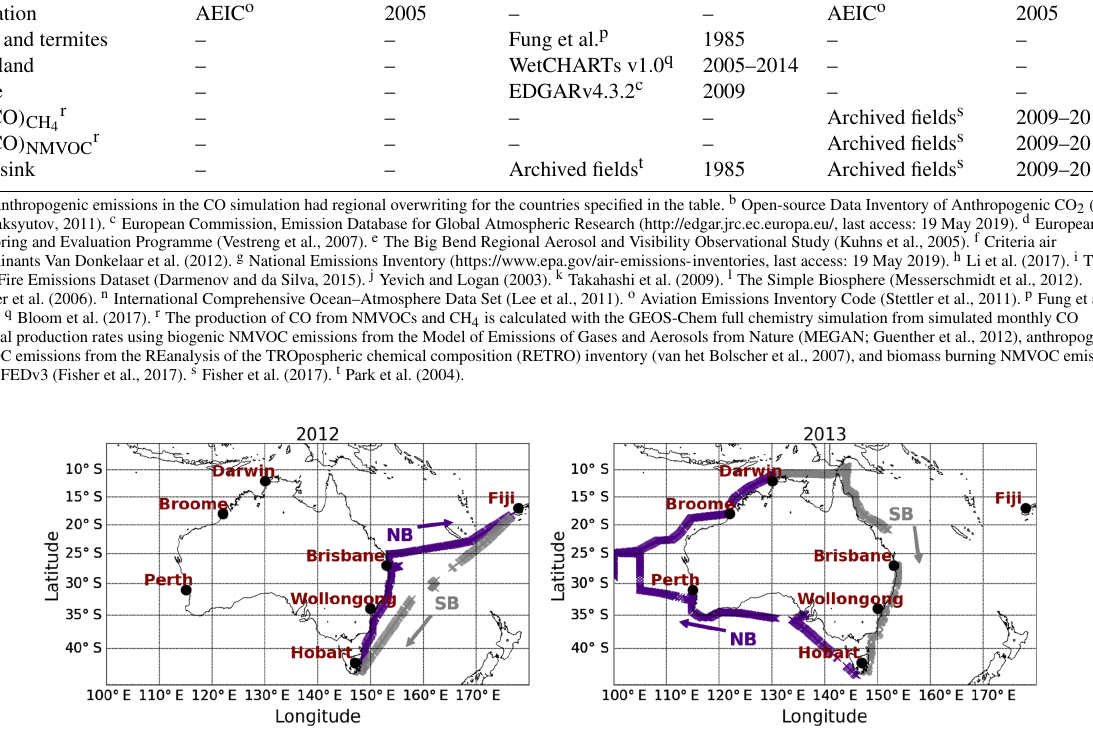
Figure 1. Locations of the shipborne measurements (purple and grey) and other sites relevant for the data interpretation (red). The ship track is separated into northbound (NB – purple; 147.5–176.6 ◦ E in 2012 and 146.1–130.9 ◦ E in 2013) and southbound (SB – grey; 176.6–146.1 ◦ E in 2012 and 130.9–147.5 ◦ E in 2013) sections to ease the interpretation of the